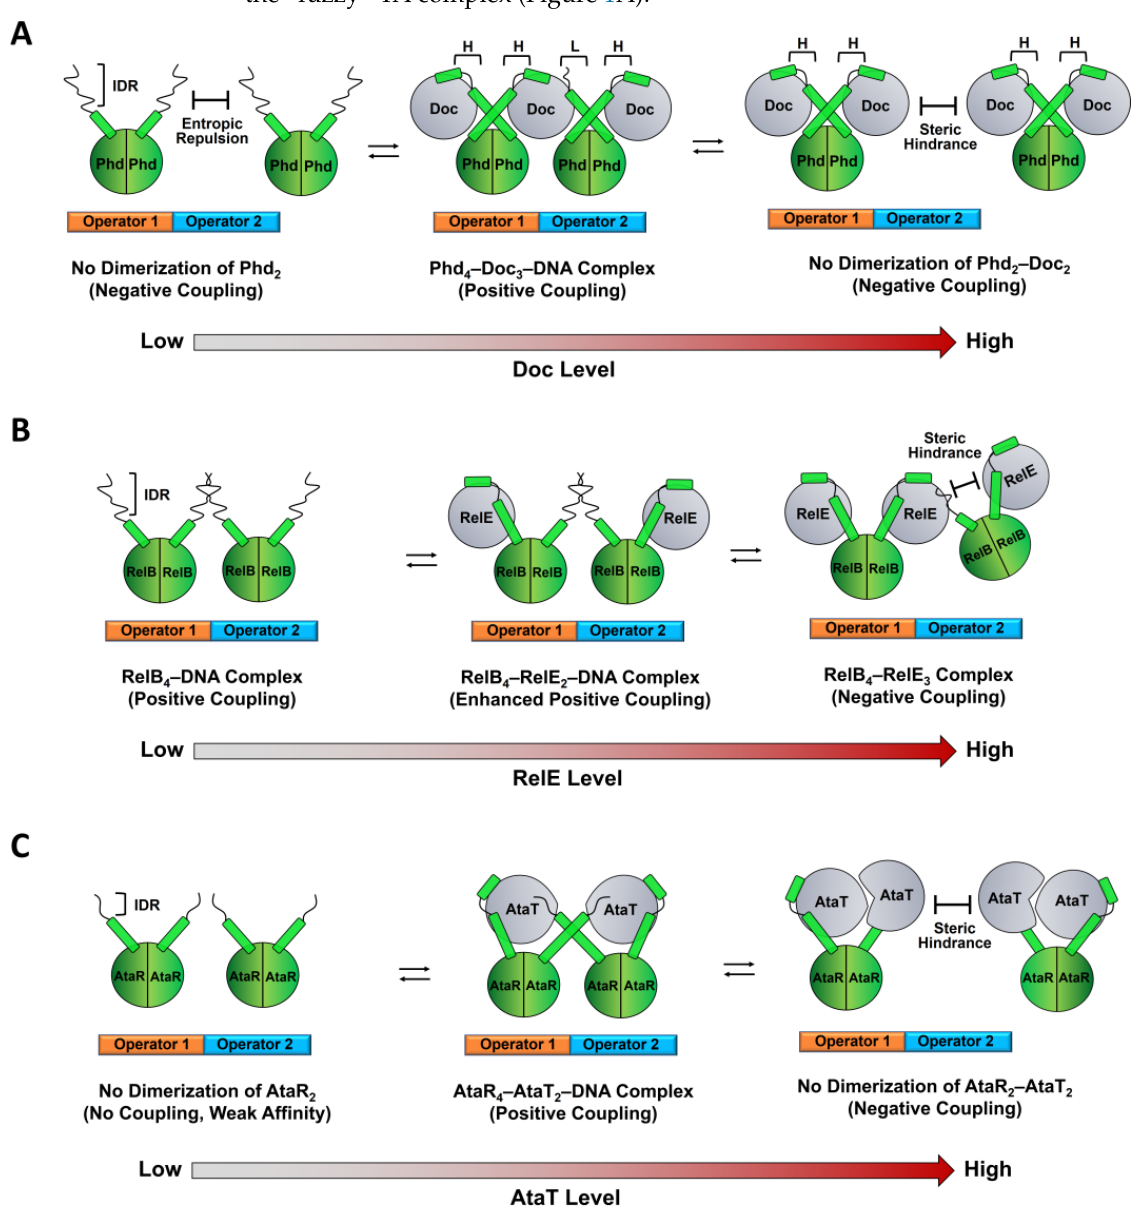
Figure 1. Schematic of the representative molecular mechanism for conditional cooperativity in the TA operon regulation. ( A ) phd-doc. The C-terminal IDR of Phd that associates with its own operator inhibits the binding of a second Phd dimer to the adjacent operator at low Doc-to-Phd ratios. This mechanism involves an entropic repulsion of the Doc-free IDR of Phd against another Phd IDR, leading to a negative cooperativity and weak transcriptional repression. As the level of Doc in- creases, binding of Doc induces the folding of the IDR to reduce the entropic repulsion and promotes